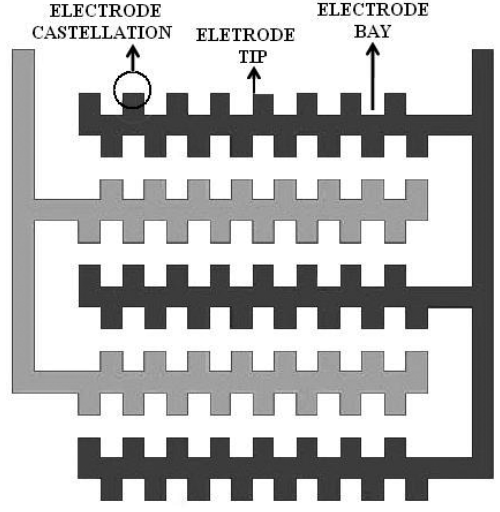
Fig. 2 – Classical interdigitated castellated microelectrode pattern, solved by a FEM model with a castellation size and medium height of 50 μ m and an electrode thickness of 1 μ